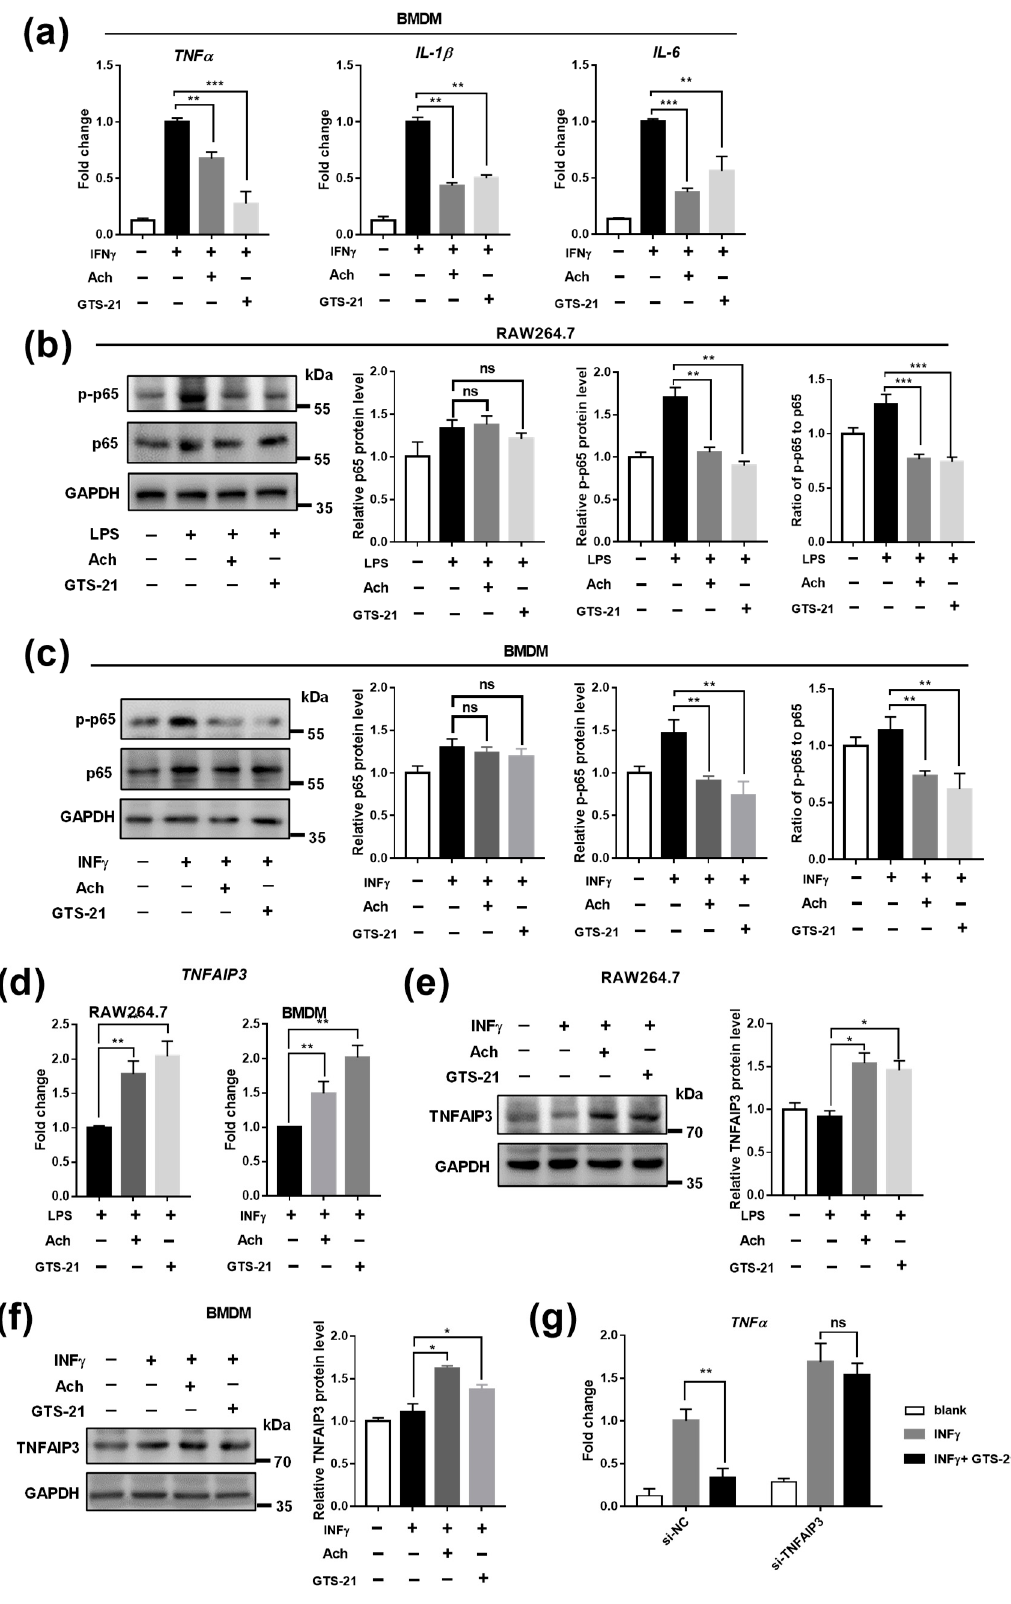
Figure 3. Effects of CAP agonists on M1 macrophage polarization. ( a ) The mRNA expression of M1 type marker genes (i.e., TNF α , IL-1 β , and IL-6 ) were suppressed by the treatment of Ach and GTS-21 in INF γ induced BMDM. Data are presented as means ± SD ( n = 3 biological replicates). ** p < 0.01, *** p < 0.001 as compared to INF γ induced cells. ( b ) Repre- sentative immunoblot images and quantitative analysis of inflammatory-related genes in LPS induced RAW264.7 cell treated with Ach and GTS-21. Data are presented as means ± SD ( n = 3 biological replicates). ** p < 0.01 as compared to LPS-induced cells, ns indicates not significant. ( c ) Representative immunoblot images and quantitative analysis of inflam- matory-related genes in INF γ induced BMDM treated with Ach and GTS-21. Data are presented as means ± SD ( n = 3 biological replicates). * p < 0.05, ** p < 0.01 as compared to INF γ induced cells, ns indicates not significant. ( d ) The mRNA expression of TNFAIP3 was upregulated by the treatment of Ach and GTS-21 in LPS/INF γ induced RAW264.7 and BMDM. Data are presented as means ± SD. ** p < 0.01 as compared to LPS/INF γ induced cells. ( e and f ) Representative immunoblot images and quantitative analysis of TNFAIP3 in RAW264.7 ( e ) and BMDM ( f ) treated with Ach and GTS-21. Data are presented as means ± SD ( n = 3 biological replicates). * p < 0.05 as compared to INF γ induced cells. ( g ) GTS-21 inhibited expression of TNF α was restored by siRNA interference of TNFAIP3. Data are presented as means ± SD ( n = 3 biological replicates). ** p < 0.01, ns indicates not significant. 3.4. Effects of CAP Agonists on M2 Macrophage Polarization Next, we determined the role of CAP activity in M2 macrophage polarization. By the treatment of Ach or GTS-21, the expression of M2 macrophage marker genes, such as Arg1 , TGF β , IL-10 , Mrc1, and Retnla , were significantly upregulated in RAW264.7 cells (Supple- mentary Figure S4). In addition, BMDM cells were also stimulated with IL4 for M2 mac- rophage activation, and we found that the CAP agonists enhanced the expression of M2 maker genes (Figure 4a–c), further confirming the positive role of CAP in promoting M2 macrophage polarization. Since the STAT3 and STAT6 pathways are known to regulate M2 macrophage polar- ization [63–66], we then investigated whether these signalings are involved in the CAP pathway. The data revealed that both Ach and GTS-21 stimulation promoted the activa- tion of pSTAT3 but not pSTAT6 in IL4-induced BMDM (Figure 4d–f). To confirm the in- volvement of STAT3 in mediating the function of GTS-21, we knocked down the STAT3 levels by transfecting siRNAs of STAT3 (Supplementary Figure S5a) and found that GTS- 21 induced M2 marker gene Arg1 was blocked by siSTAT3 (Figure 4g). Thus, these find- ings indicate that CAP activation is likely to facilitate M2 macrophage polarization through the activation of STAT3 signaling.